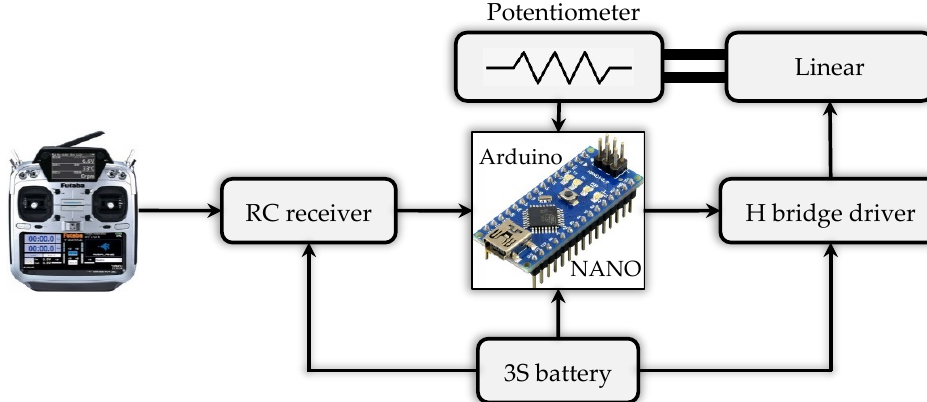
Figure 5. Block diagram of the control electronics.